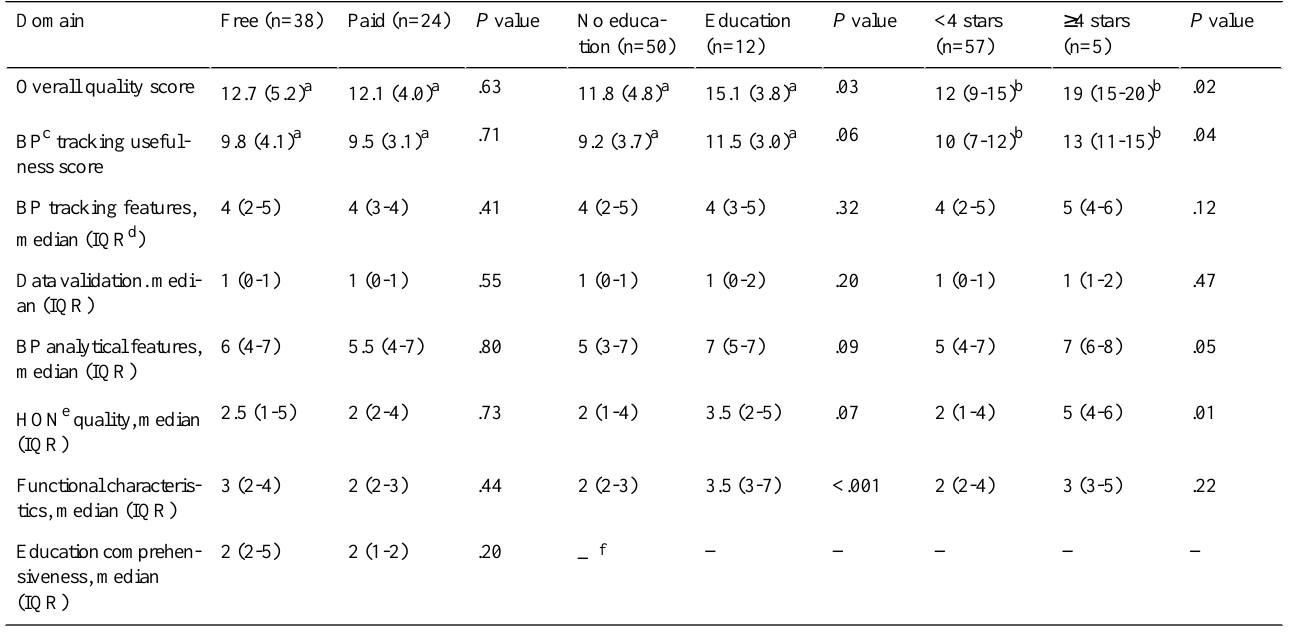
Table 4. Comparison of hypertension app domain and overall quality scores by cost, presence of educational content, and user rating